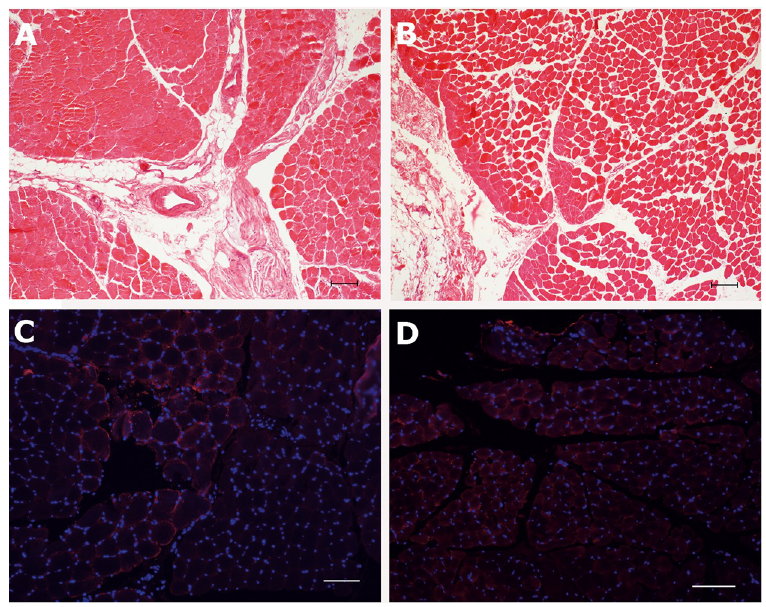
Fig 3. Representative histology of the perfused CAD and evaluation of HIF-1 α distribution. A displays a Hematoxylin-Eosin staining of a non-perfused normal equine CAD-biopsy for histological comparison. In B , the perfused muscle tissue shows interstitial edema. Note the loosened connection of the muscle fibers with low amounts of poorly stained edema fluid. The perimysial borders are still distinguishable. C and D show immunofluorescent analysis of HIF-1 α in the CAD-sections before and after perfusion. A diffuse weak staining within the muscle fibers can be observed (red). No intranuclear signal can be detected.